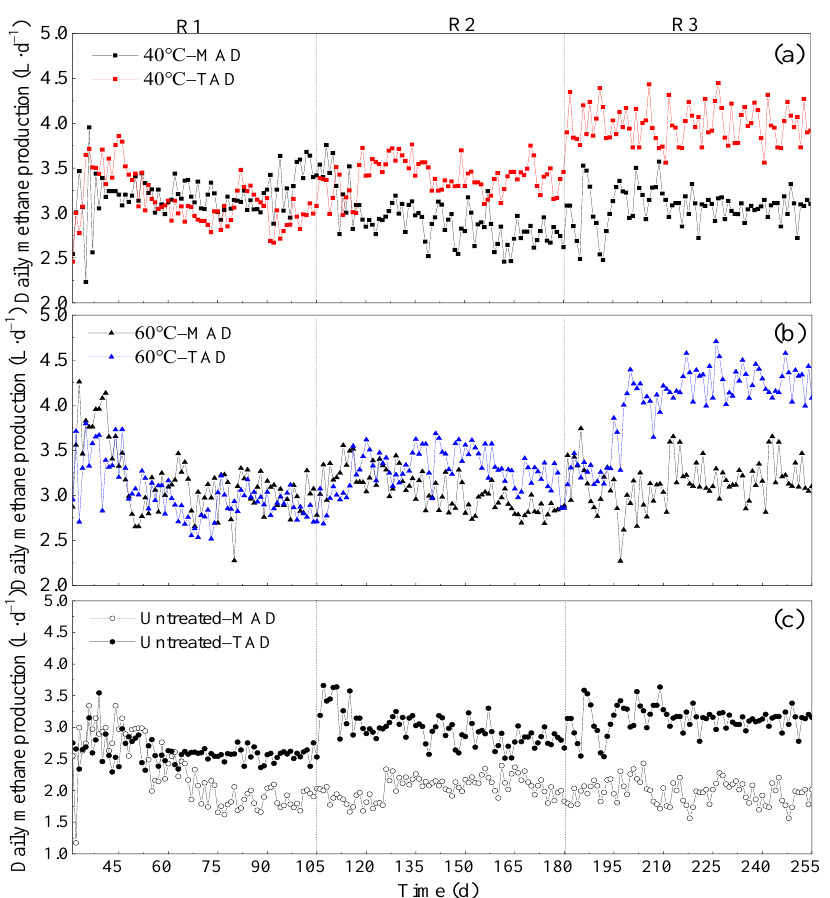
Figure 3. ( a – c ). Daily methane production of different pretreatment and anaerobic digestion temperatures. ( a ): 40 °C group; ( b ): 60 °C group; ( c ): untreated group.